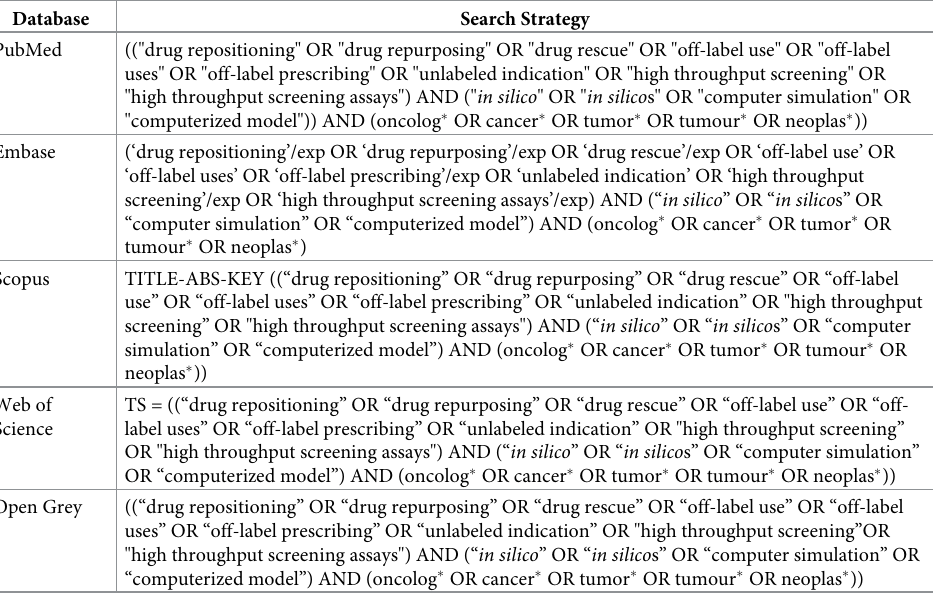
Table 1. Search strategies according to the electronic